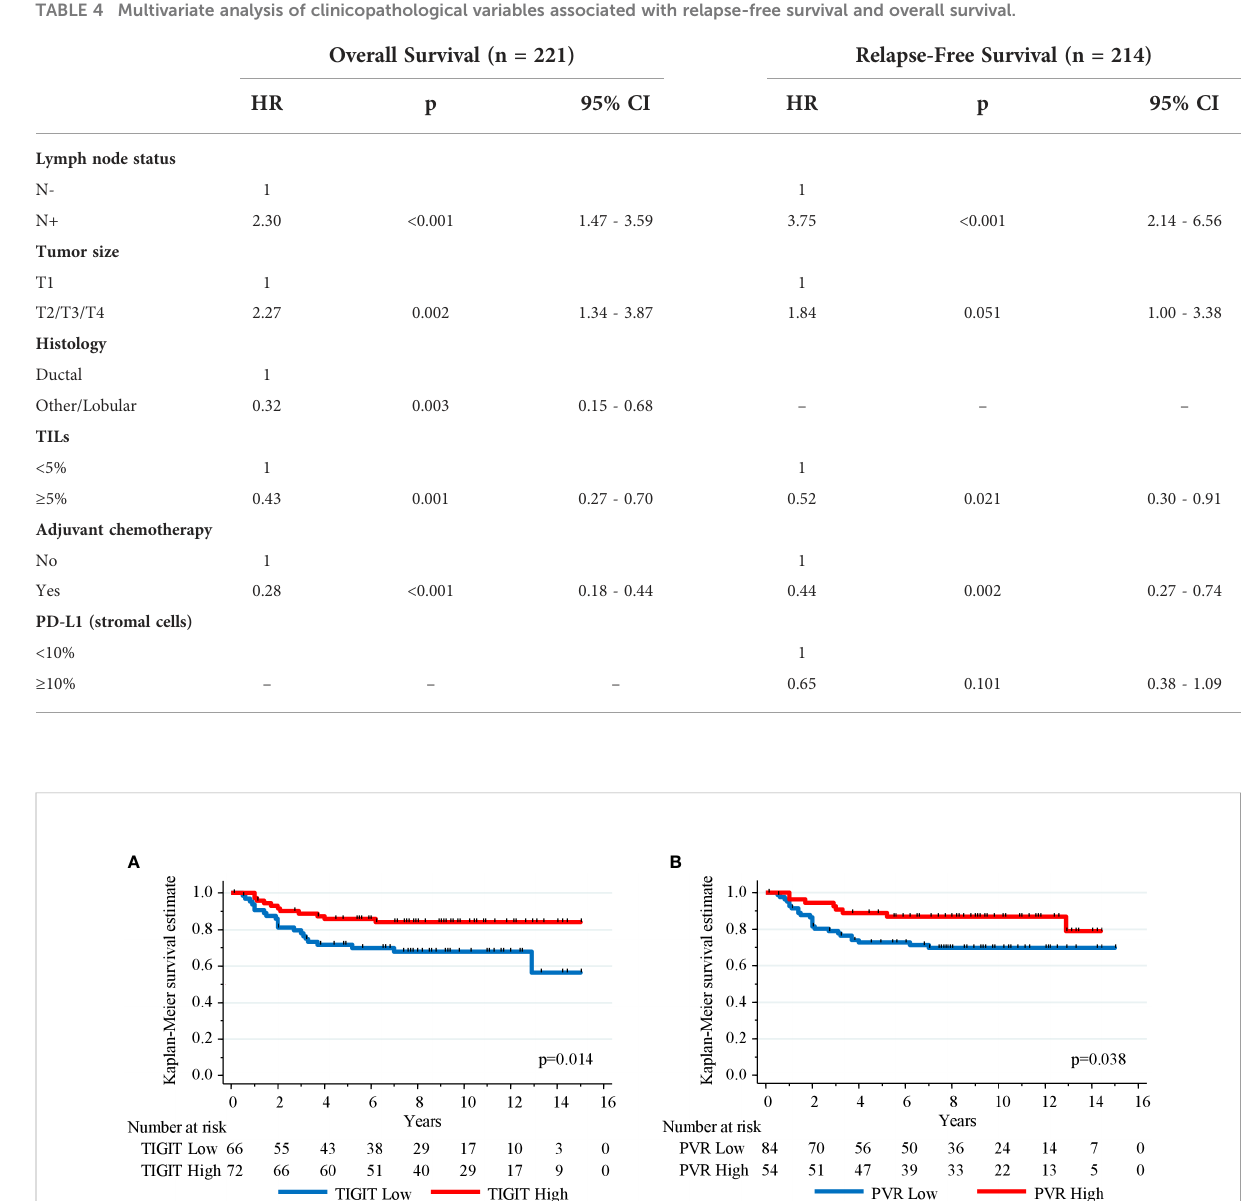
FIGURE 3 Kaplan-Meier curves showing relapse-free survival estimation in 138 TNBC samples with non-molecular apocrine phenotype (androgen receptor- and FOXA1-negative) strati fi ed according to (A) TIGIT + cell density and (B) PVR expression